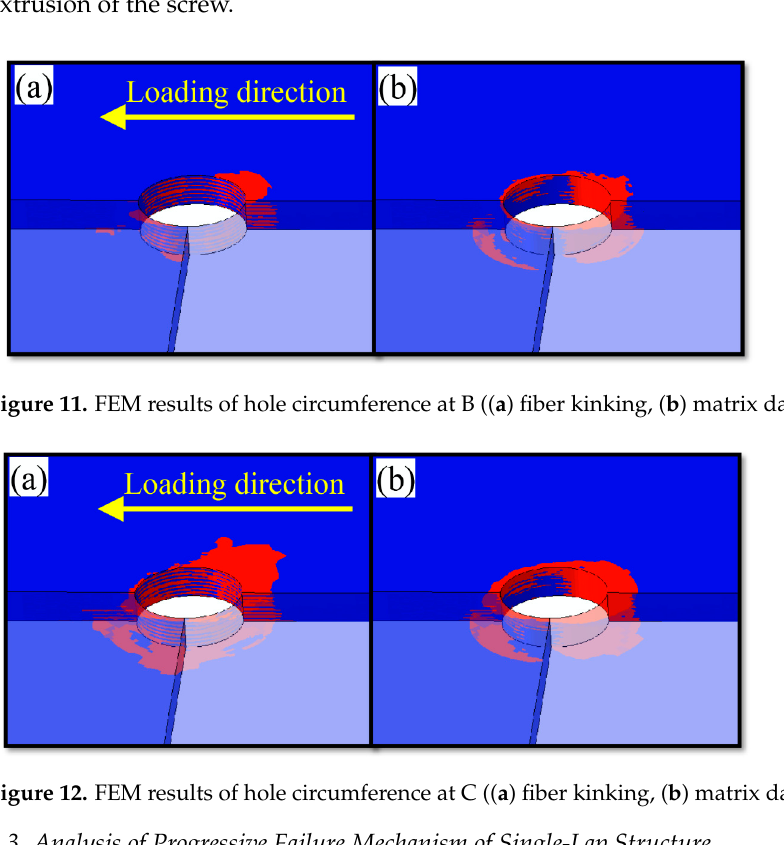
Figure 10. FEM results of circumferential section at B (( a ) fiber kinking failure, ( b ) matrix damage).